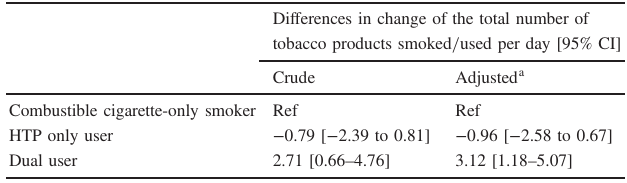
Table 4. Di ff erences between smoking groups in change of the total number of tobacco products smoked / used per day from baseline to follow-up (overall population)